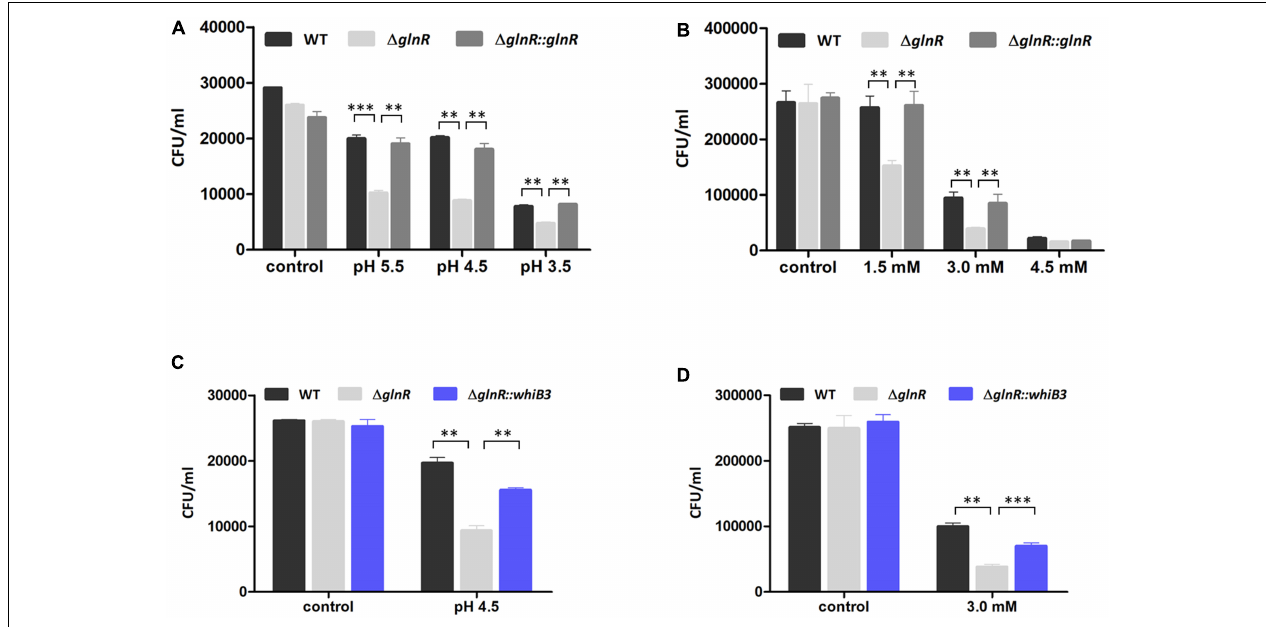
FIGURE 4 | GlnR influenced the resistance of M. smegmatis to acidic and oxidative stress. (A) Effect of different pH condition on survival of WT, (cid:49) glnR and (cid:49) glnR -complemented strains grown in N L Sauton’s medium. (B) Effect of different H 2 O 2 concentration on survival of M. smegmatis strains grown in N L Sauton’s medium. (C) Survival of WT, (cid:49) glnR and (cid:49) glnR :: whib3 strains grown in N L Sauton’s medium with pH 4.5. (D) Survival of WT, (cid:49) glnR and (cid:49) glnR :: whib3 strains grown in N L Sauton’s medium with 3 mM H 2 O 2 . Error bars showed standard deviations from three independent experiments. ∗∗ P < 0.01, ∗∗∗ P < 0.001.